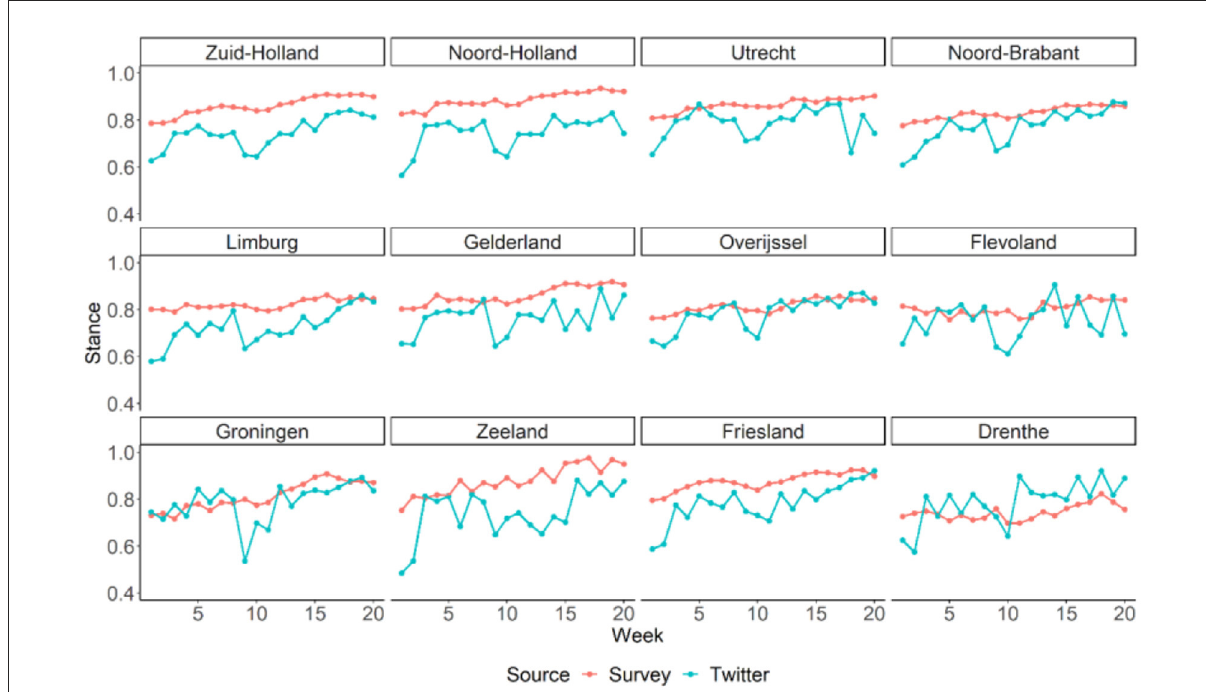
FIGURE3 Temporal variation of stance on social distancing in Dutch provinces estimated from Twitter and survey data. Provinces are ordered from left to right and top to bottom based on their population density. The y-axis is restricted to [0.4, 1] in order to show the temporal changes more